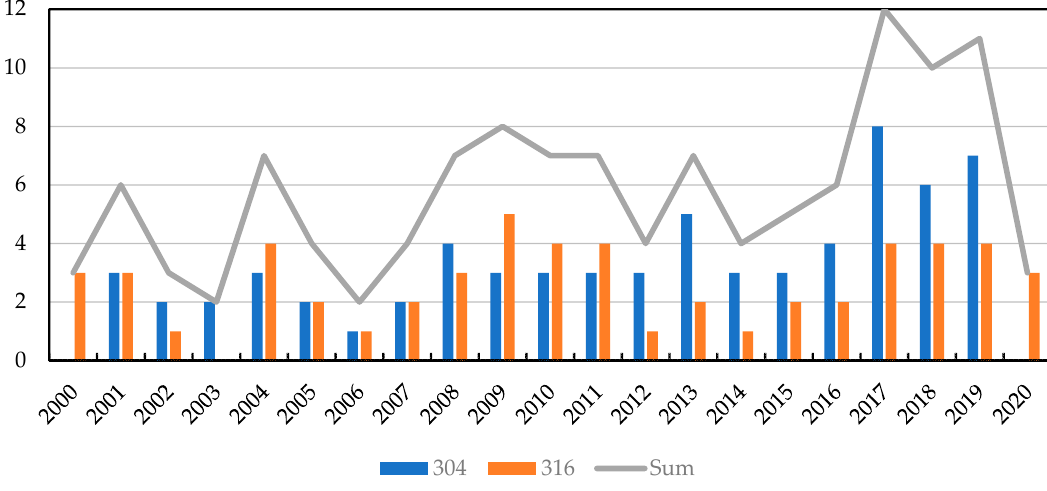
Figure 3. Number of considered scientific publications on similar and dissimilar diffusion bonding and TLP bonding of 304 and 316 stainless steel over the last 20 years.